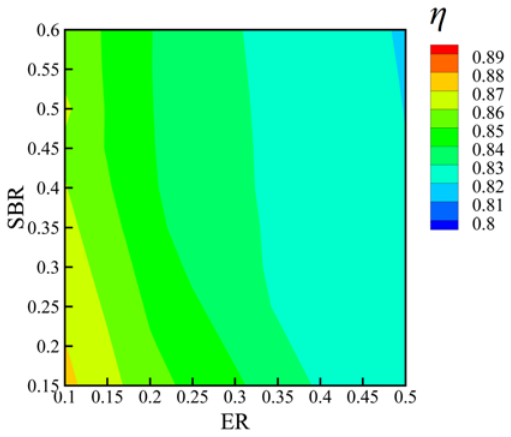
Figure 24. Exergy efficiency distribution at T = 1000 K.